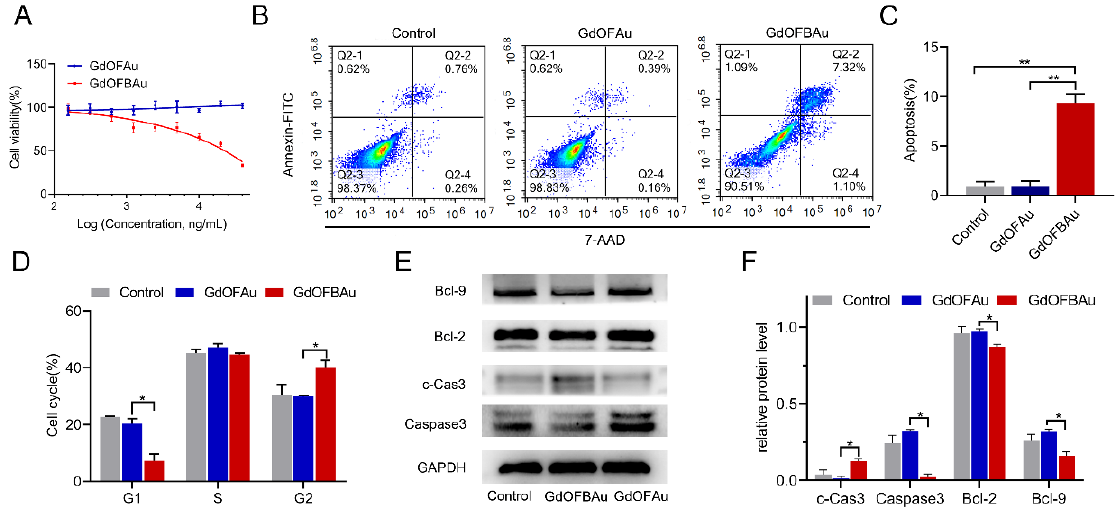
Figure 3. In vitro anticancer efficacy and mechanism of GdOFBAu on MC38 cells. ( A ) MC38 cells were treated with increasing concentrations of drugs, as determined by the MTT assay, after 48 h incubation. ( B , C ) Quantitative analysis of the apoptosis of MC38 cells induced by the indicated drugs, as assessed by FACS analysis. ( D ) Cell cycle profiles of MC38 cells by FACS analysis. ( E , F ) The protein expression of c-Cas3 (cleaved-Caspase3), Caspase3, Bcl2 and Bcl9 in MC38 cells after drug treatment was measured by Western blot assay. p -values were determined by student’s t -test: **, p ≤ 0.1; * , p ≤ 0.5.